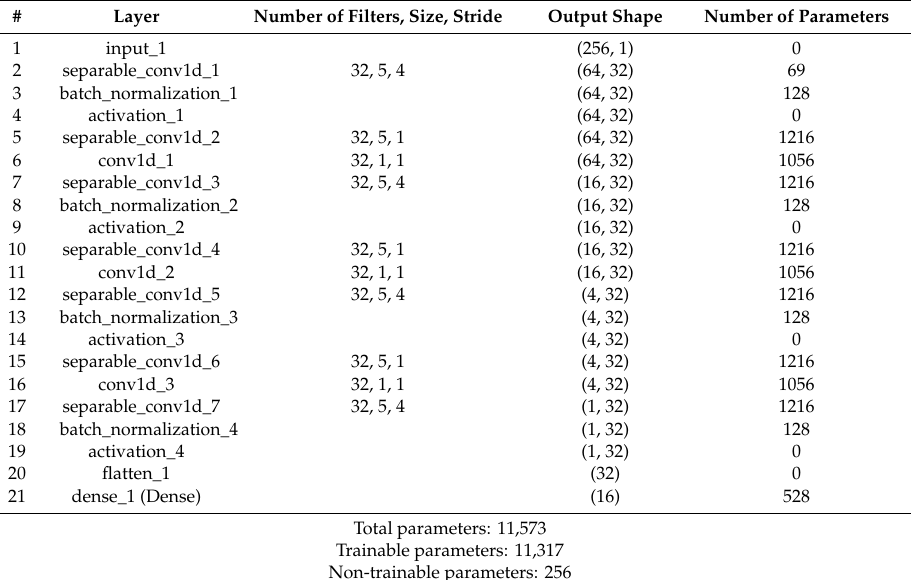
Figure 4. CNN Models with and without the depthwise separable algorithm. Table 2. Depthwise separable CNN model summary.